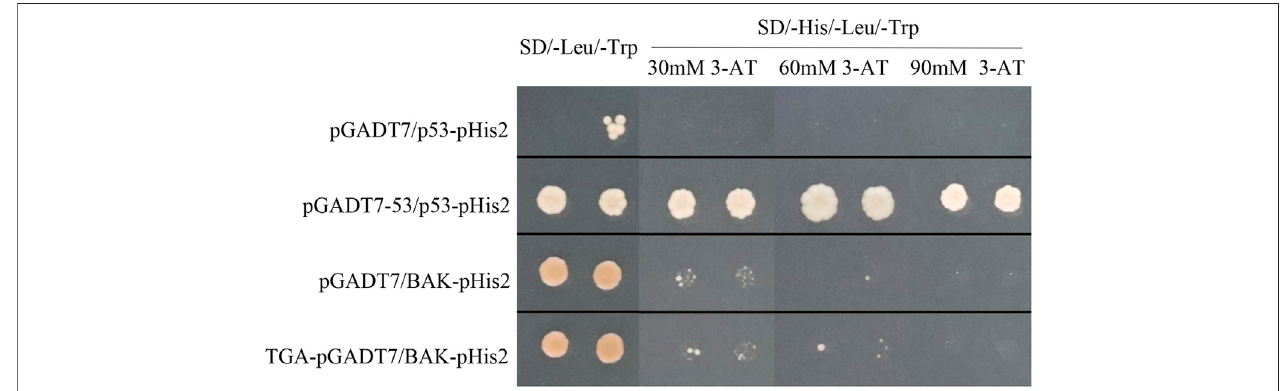
FIGURE 9 | Y1H showing the association of StTGA39 with the promoter of the StBAK1-20 gene. Y1H assay for determination of StTGA39-StABAK1- 20interaction.Growth ofyeastcellstransformedwiththeeffectorvectorand thereportervectoronSD(-His,-Leu,-Trp) supplementeddifferentconcentrationsof3-AT. The positive control is pGADT7-53/p53-pHis2 vector and negative control is pGADT7/p53-pHis2